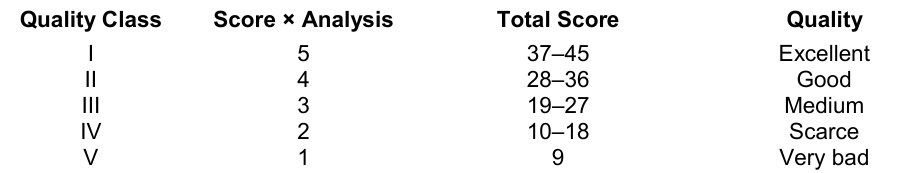
Method for Translating the Macrobenthos Quantity Data in Functional